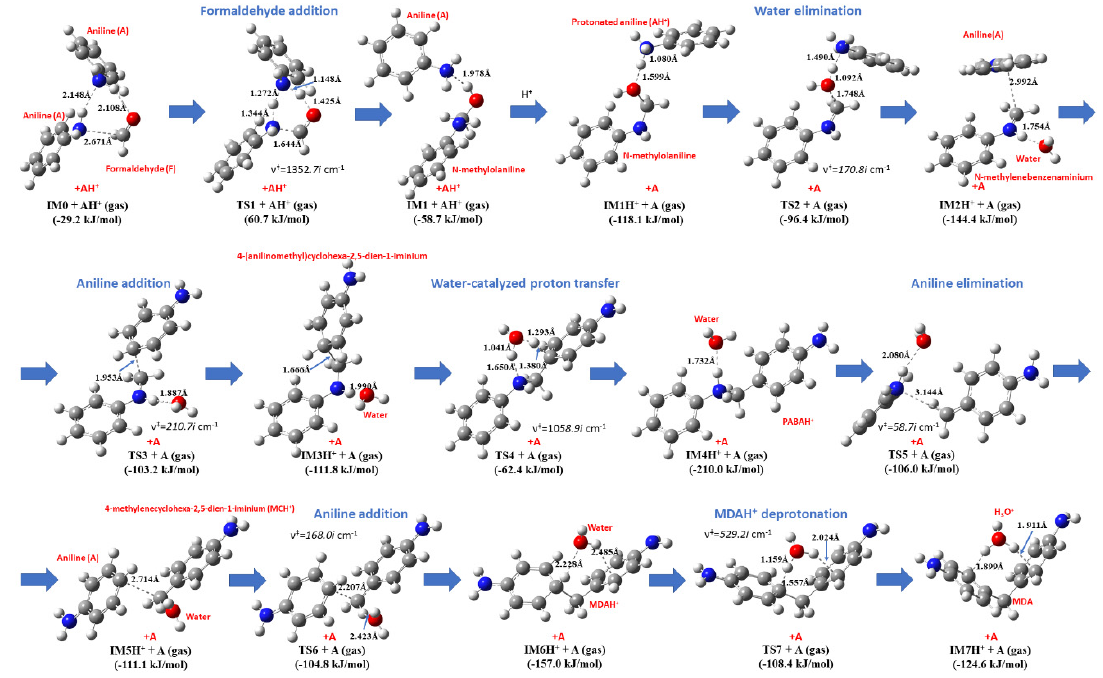
Figure 3. Transition state structures (obtained at B3LYP/6-31G(d) level of theory) for MDA synthesis in gas phase. The G3MP2B3 relative energies are also given.